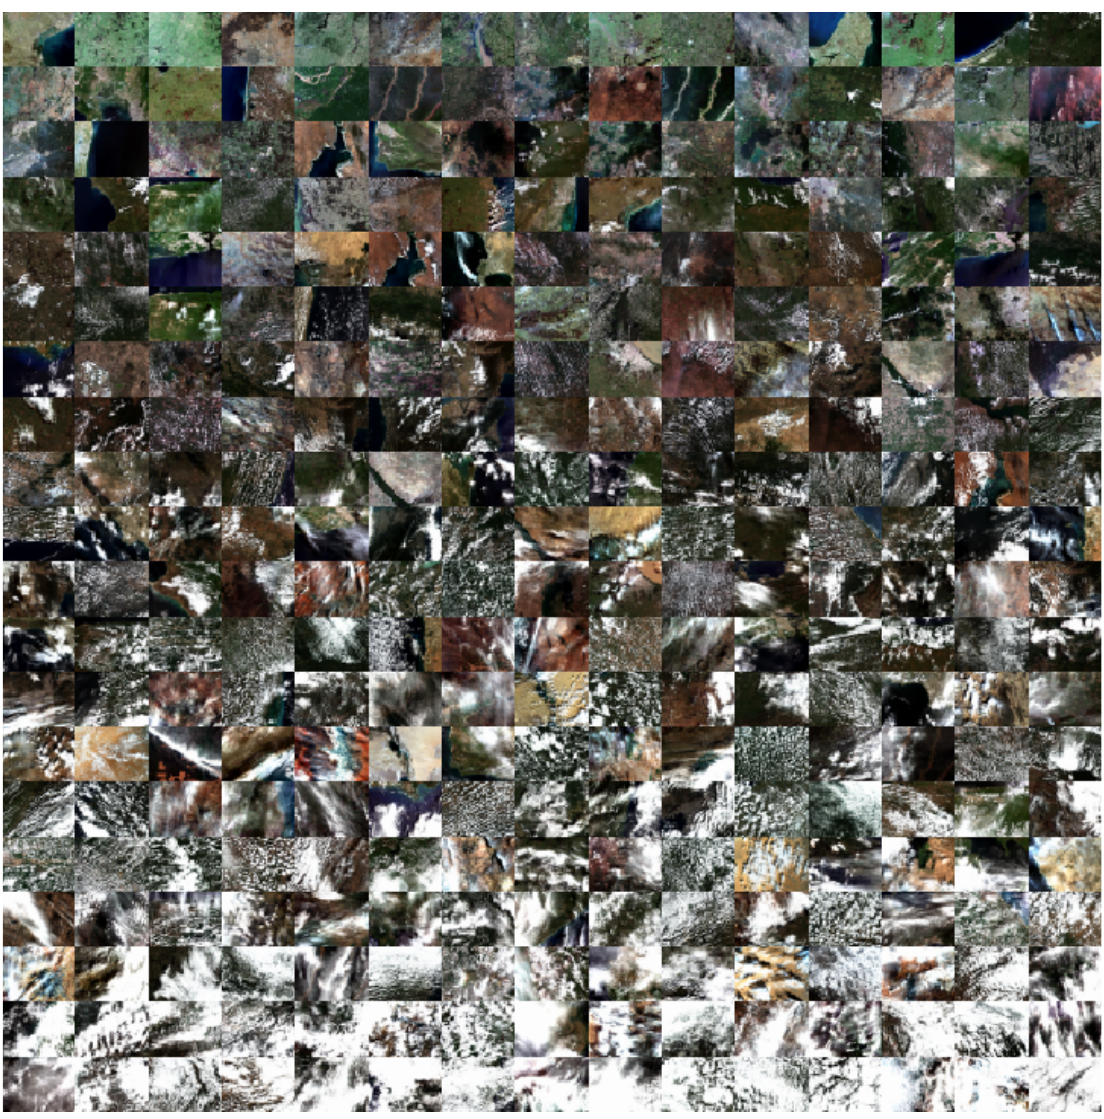
Figure 16. Visualization of image prioritization using NU-Net with patch decomposition of 16 × 16 patch. The images with the highest priority have been aligned from the top left corner down to the bottom right